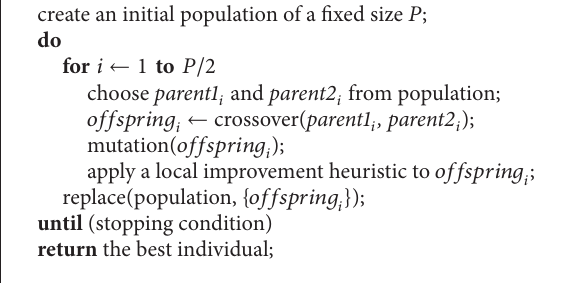
Algorithm 3: Framework of our memetic